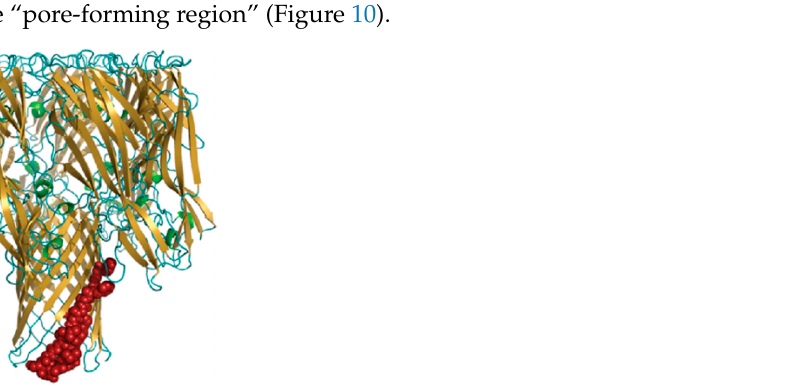
involved in AT binding to cell [86]. The important residues involved in its pore-forming mechanism have been identified, including N-terminal Arg66 and Glu70 and C-terminal Arg200, Asp254, Asp255 and Asp276 [142]. Furthermore, a determinative sequence of AT pore forming is identified, which could be referred to as a linear neutralising epitope: it is located in the β -barrel pore-forming region of AT, likely including residues 122 to 137 [141]. In addition to lysing immune and host cells, AT can contribute to biofilm formation by promoting bacterial survival, destroying the host epithelium and facilitating bacterial cell-to-cell interactions. Therefore, the antibody against AT is suggested to be a multi- mechanistic anti-biofilm strategy. This suggestion is strongly supported by studies on hu- man mAb (MEDI4893) [85]. This study shows MEDI4893 could exert its neutralising effect through a dual mechanism, as it not only blocks the binding between AT and its cellular receptor ADAM10, but it also inhibits its heptameric conformational change that enables cell lysis [85]. Furthermore, MEDI4893 has been extensively tested in a series of biofilm- associated infection models [84,85]. So far, a phase II clinical trial of MEDI4893 has been completed, which confirms its efficacy in preventing S. aureus infection (ClinicalTrials.gov Identifier: NCT02296320). In addition, another AT-neutralising antibody named as AR- 301 has successfully passed its phase IIa clinical trial on patients with hospital-acquired bacterial pneumonia (ClinicalTrials.gov Identifier: NCT01589185). Overall, AT antibodies